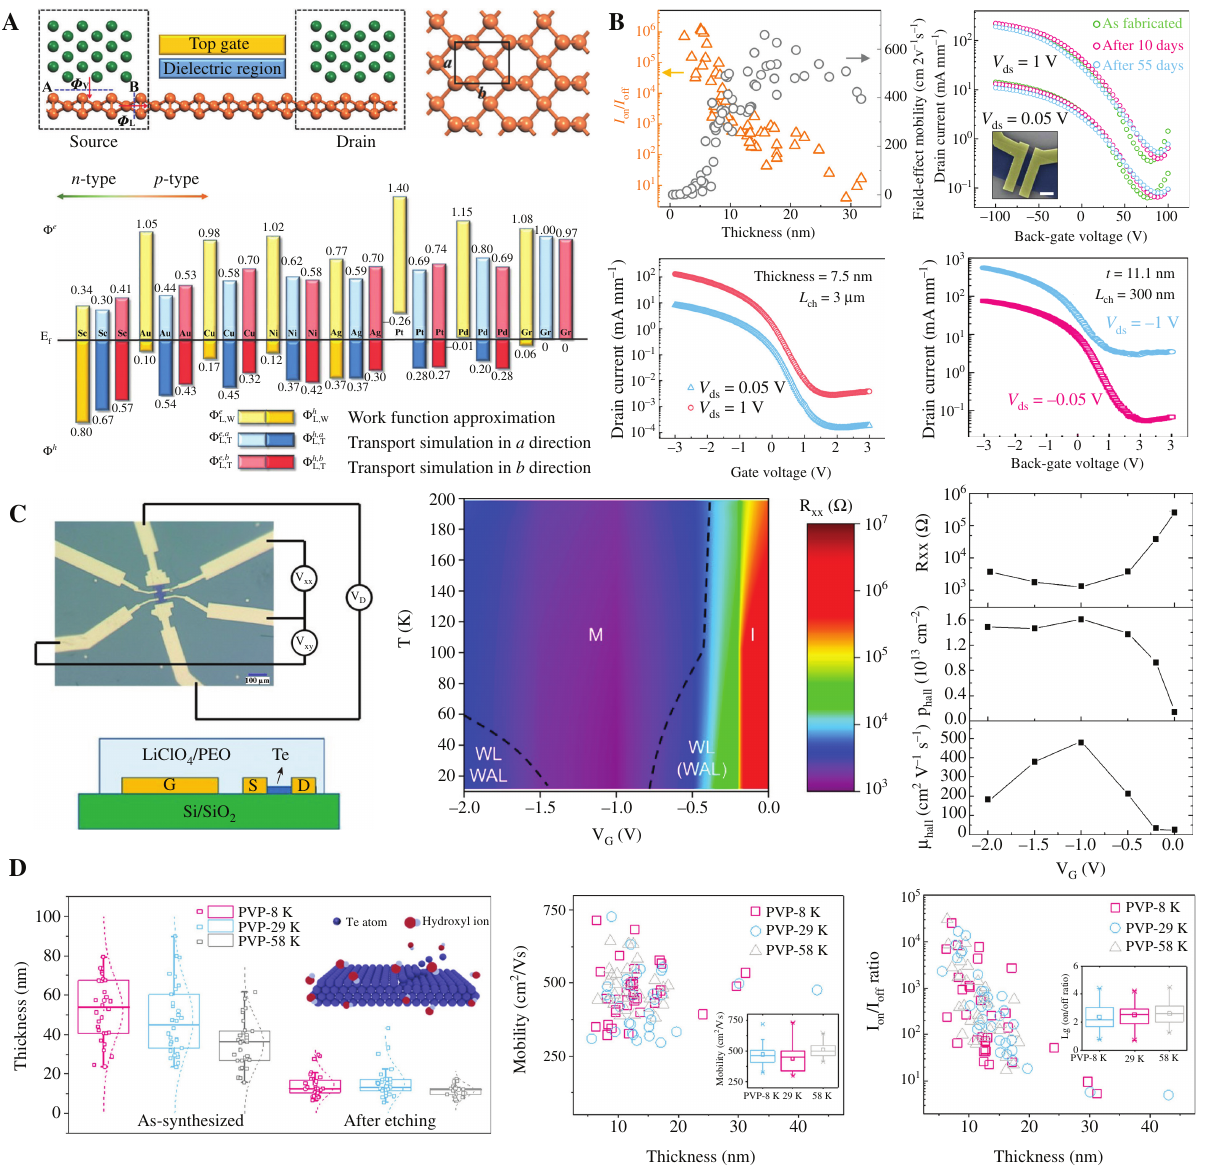
Figure 13: The performance of tellurene-based transistors. (A) Schematic of monolayer β -tellurene-based FET and the comparison of lateral SBH obtained from work function approximation and quantum transport simulation in the a and b directions. Reproduced with permission [173]. Copyright 2018, The Royal Society of Chemistry. (B) Thickness- dependent on/off ratio and field-effect mobility, excellent room temperature air stability and enhanced performance by scaling down the channel length and integrating with high- k dielectric. Reproduced with permission [174]. Copyright 2018, Springer Nature. (C) Schematic of tellurene based electrolyte-gated transistors, gate-voltage-dependent electronic phase diagram (M, metallic; I, insulating; WL, weakly localized; WAL, weakly antilocalized), gate-voltage-dependent sheet resistance R